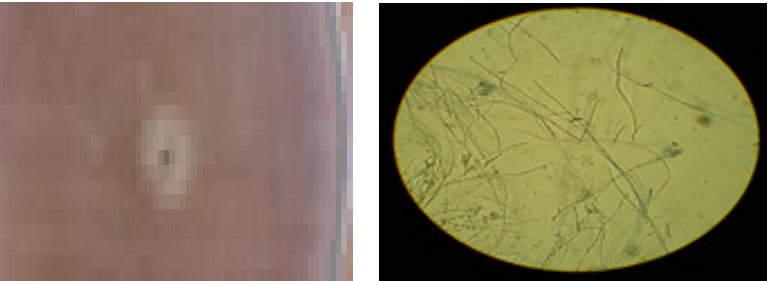
Figure 12. Macroscopic and microscopic images for penicillium brevi-compactum fungus devel- oped on the siloxane matrix . on the siloxane